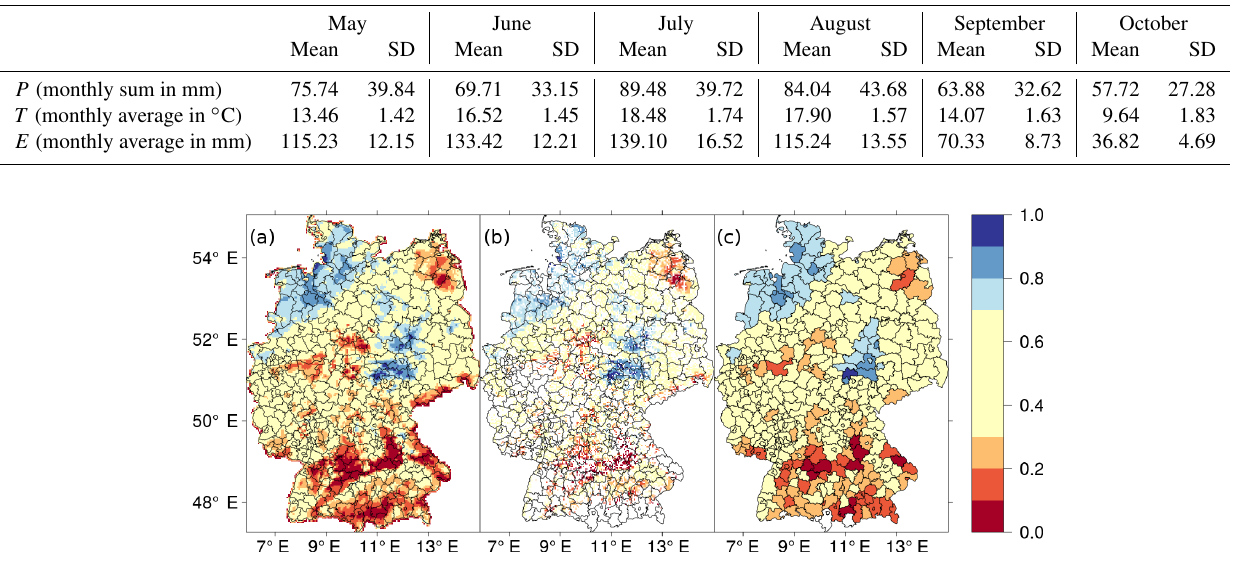
Figure 1. Illustration of the spatial processing of the SMI data of May 2003. On the left side, one can see the SMI with the 4 × 4km 2 grids. In the middle, the data are masked with the 0 . 1 × 0 . 1km 2 “nonirrigated arable land” class of the CORINE Land Cover. Those data are than averaged over all the grid cells which are inside an administrative district. This is done for each district and the map on the right is derived. The processing steps shown in panels (a) and (b) are shown here exemplary for the soil moisture index for consistency, but these processing steps are applied to soil moisture